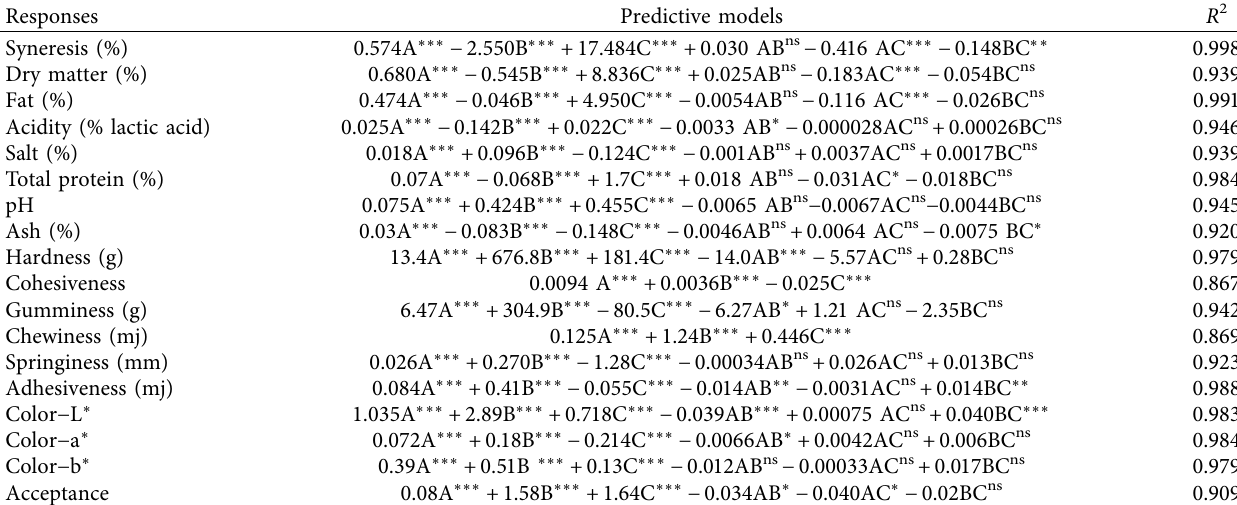
Table 2: Predictive models for characteristics of whey-less Feta cheese.